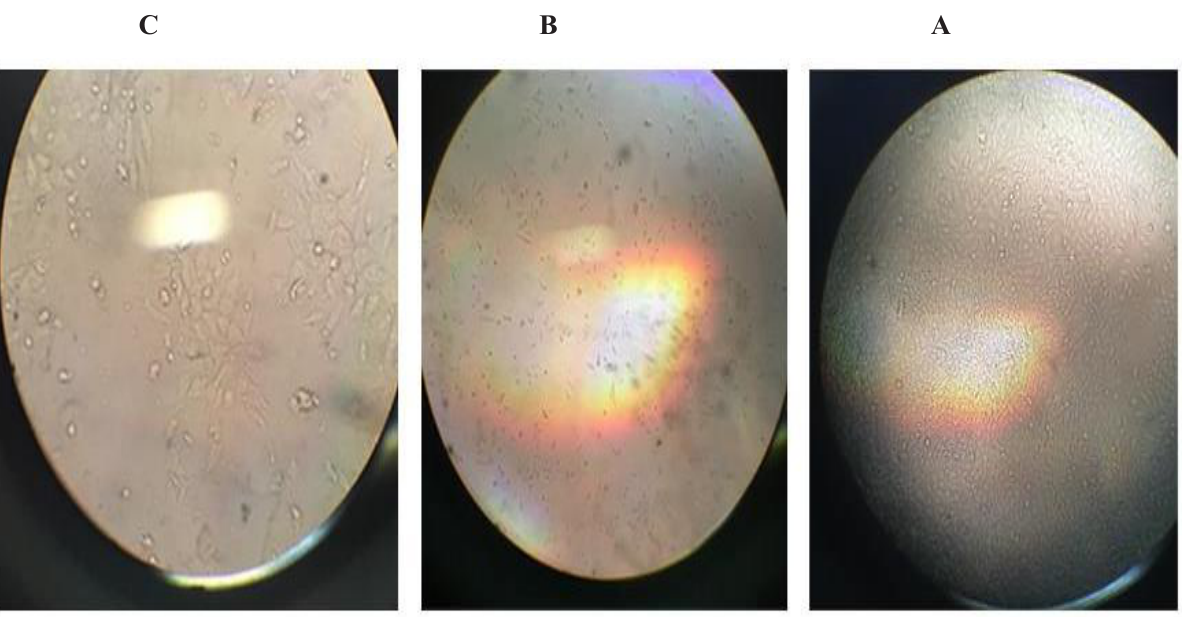
Figure 5. (A): Proliferated CHO cells before transfection. (B) CHO cells 24 hours after transfection. (C) Formation of colonies containing transfected CHO cells.